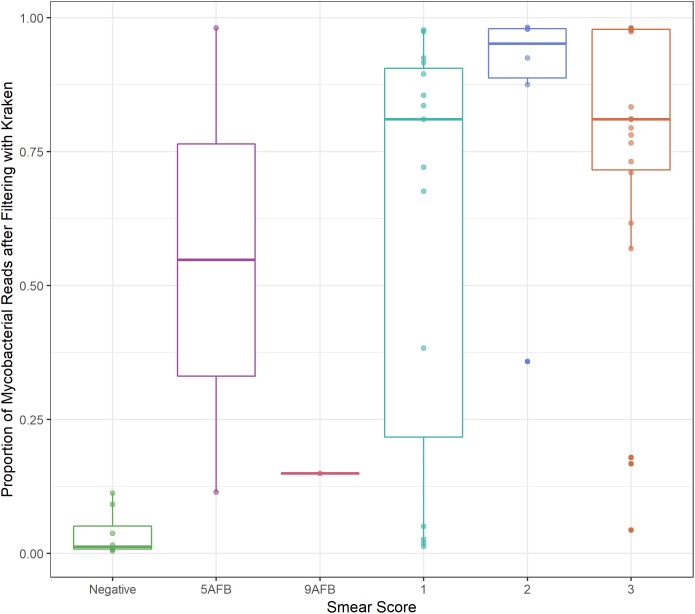
Smear score. Boxplot of proportion of sequencing data retained after filtering (y-axis) versus sputum smear score (x-axis) for M. tb sputum samples from Brown et al. Thresholds for smear score of potentially infected sputum are 0 AFB/100 fields: smear negative, 1–9 AFB/100 fields: actual number of AFB seen on slide, 10–99 AFB/100 fields: 1+, 1–10 AFB/field in 50 fields: 2+,>10 AFB/field in 20 fields: 3+, where AFB corresponds to the number of acid-fast bacilli present.